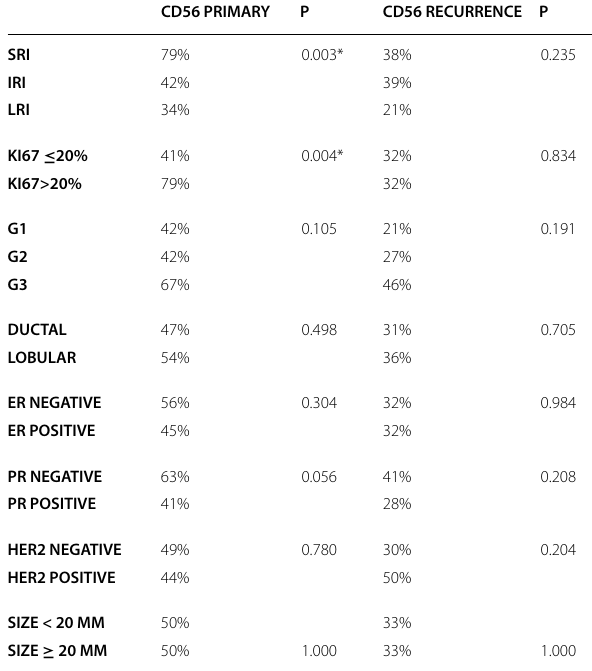
Table 4 CD56 cells in primaries and recurrences +